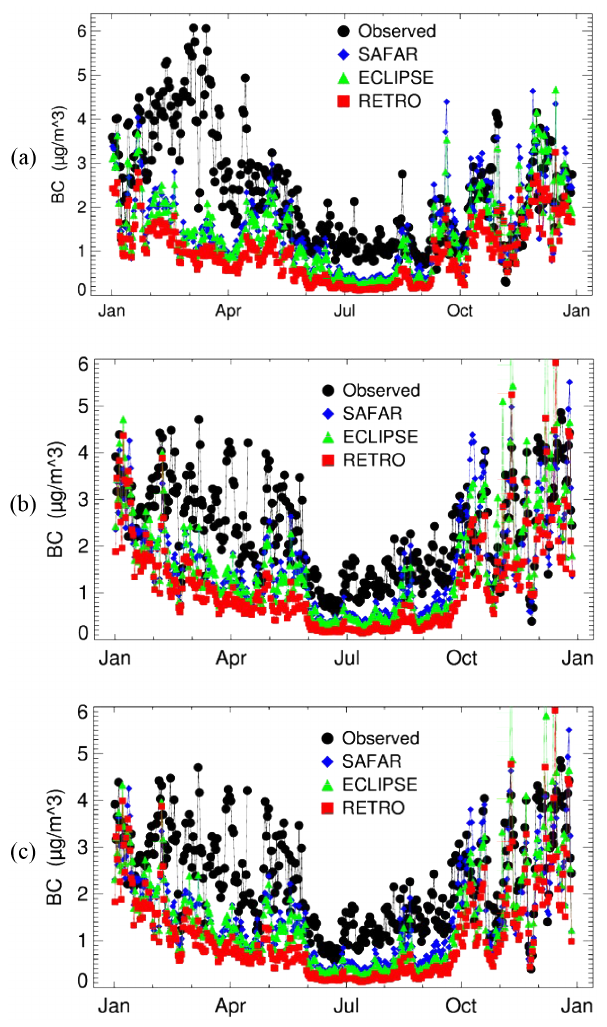
Figure 7. Comparison of observed and model estimated BC con- centration: (a) 2009 without wet deposition, (b) 2011 without wet deposition, (c) 2011 with wet deposition.